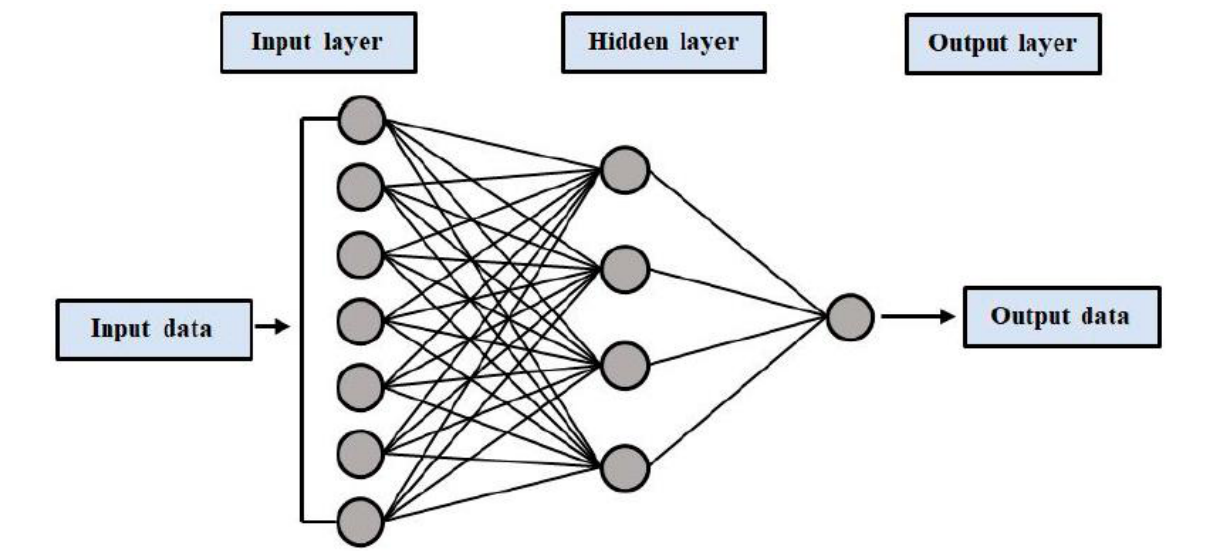
Figure 1. Architecture of a typical neural network [49].